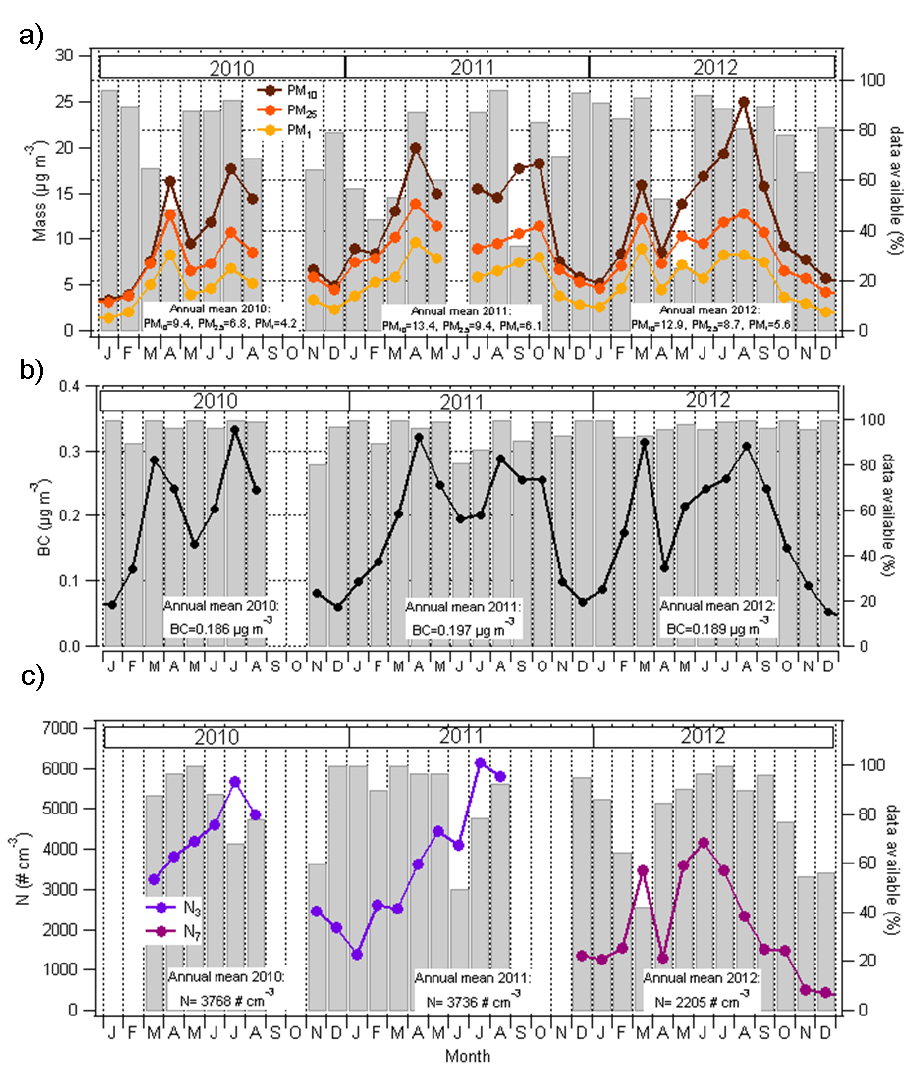
Fig. 9. Time series of monthly averaged (a) PM, (b) BC, and (c) N measured at